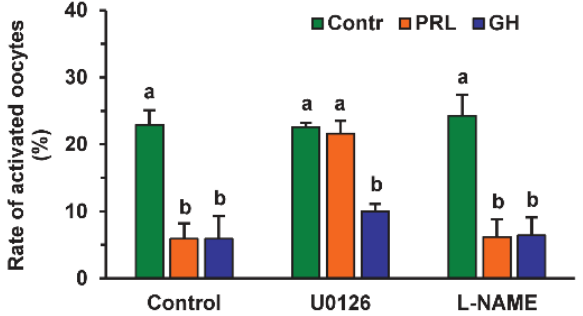
Figure 3. Effects of PRL (50 ng/mL) and GH (10 ng/mL) on spontaneous parthenogenetic activation during the 44 h aging of bovine DOs in the presence and in the absence of U0126 (20 µM), the MEK 1/2 inhibitor, and L-NAME (20 µM), the efficient eNOS and nNOS inhibitor (20 µM). Data derived from 4 independent replicates (a total of 71–80 oocytes per each treatment group) are expressed as means ± SEM. Different letters indicate significant differences between means (at least p < 0.05).